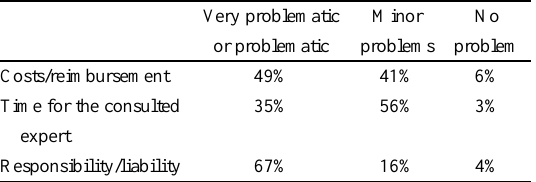
Potential difficulties of telemedicine as seen by Austrian pathologists (full results published